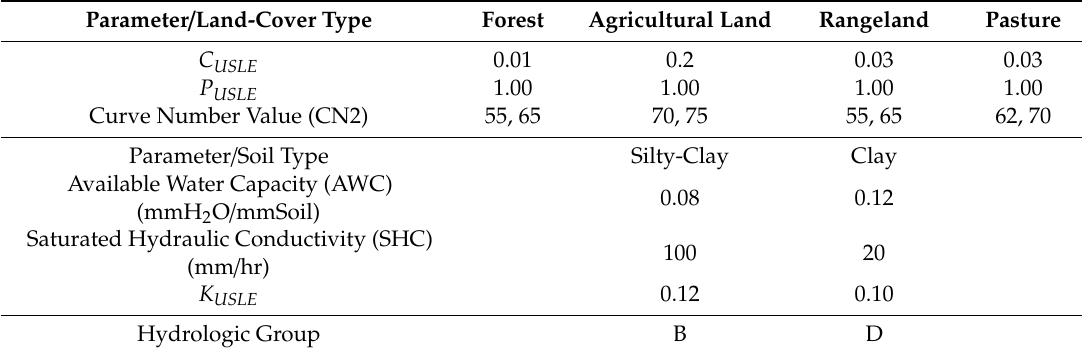
Table 1. Calibration values of six crucial SWAT parameters in determining water and sediments from di ff erent hydrologic response units (HRUs) in